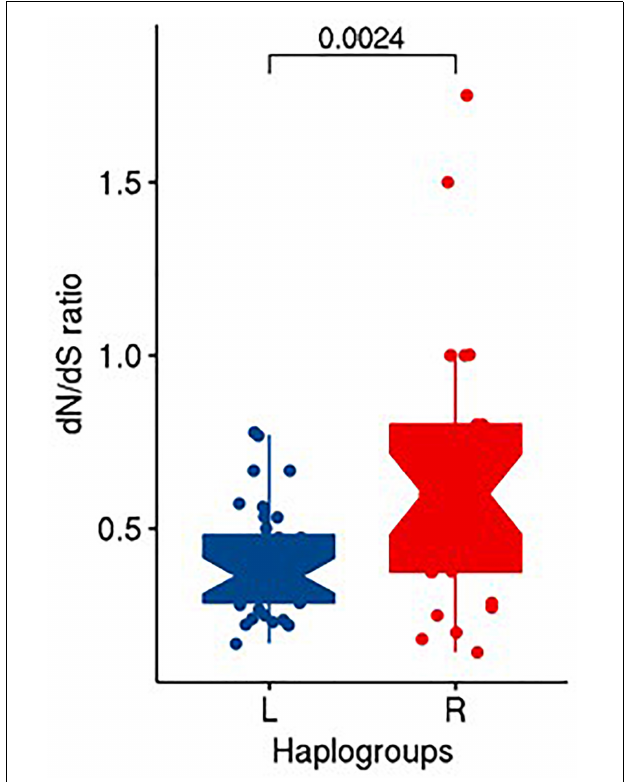
FIGURE 5 | Distribution of dN/dS ratio in R and L